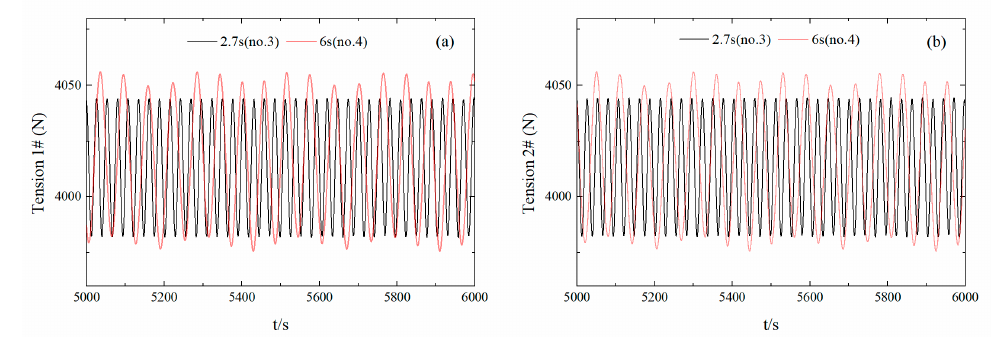
Figure 16. Time-history tension curves for the float chain with different wave periods. (Sub-figures: ( a ) time-history curves of anchor chain I tension; ( b ) time-history curves of anchor chain II tension.)